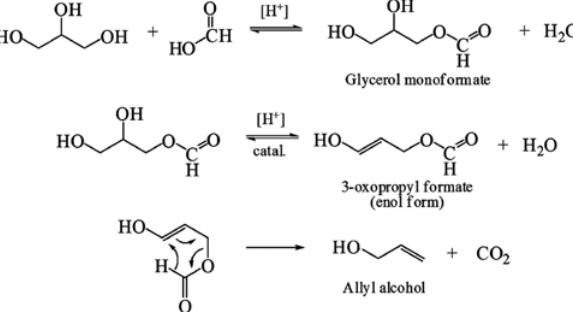
Figure 2: Multi-step reaction mechanism for the production of allyl alcohol from glycerin and formic acid.